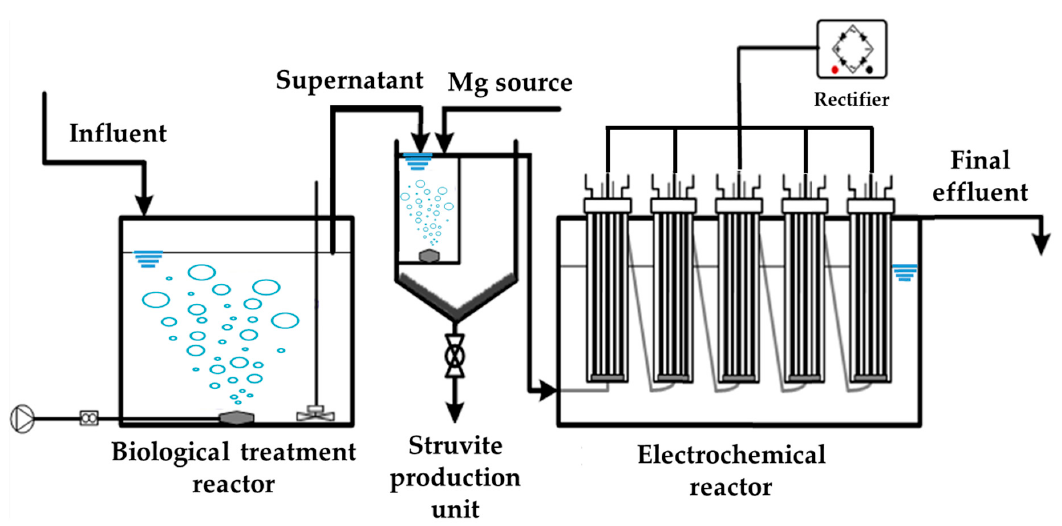
Figure 3. Schematic of the farm-scale treatment process.